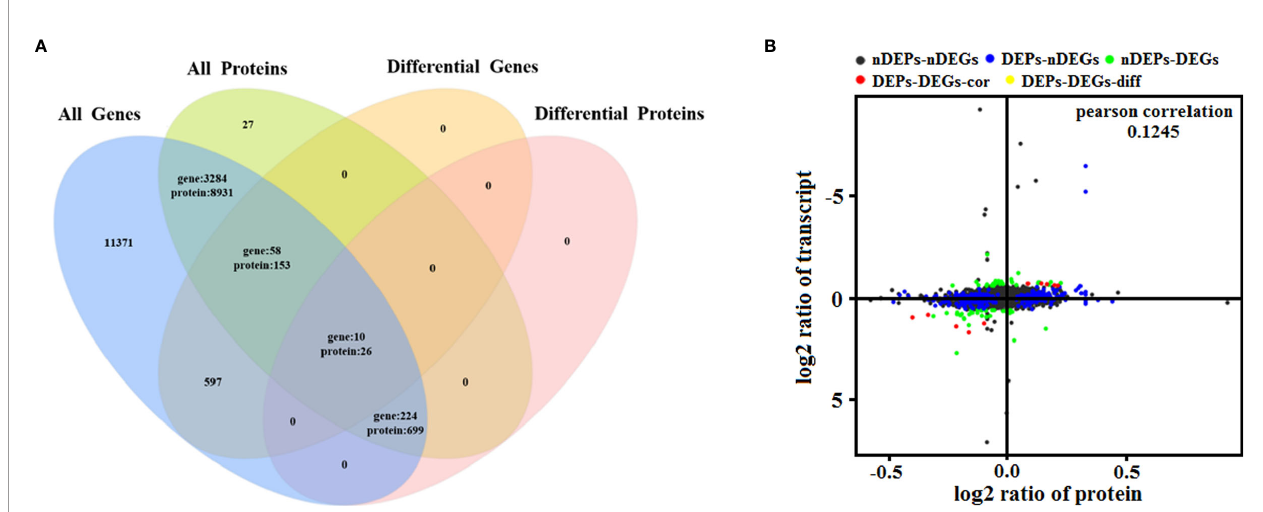
FIGURE 6 | Quantitative analysis of transcriptome proteome associations. (A) Venn diagram of all mRNAs and proteins. ‘ All genes ’ represents the detected genes, and ‘ All proteins ’ represents the detected proteins. (B) In the four quadrant diagram, the differential genes and differential proteins were screened according to the threshold of transcriptome and proteome. The black dots represent non-DEPs and non-DEGs, the green dots represent DEGs but non-DEPs, the blue dots represent DEPs but non-DEGs, the red dots represent DEGs and DEPs with the same trend, and the yellow dots represent DEGs and DEPs with the opposite same